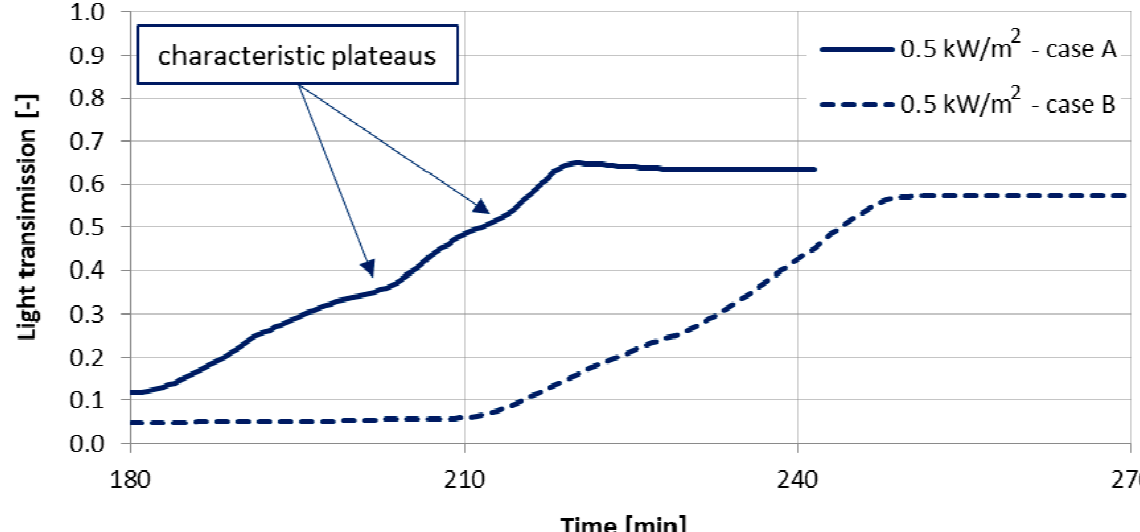
8 of 13 Figure 10. Direct light transmission versus time for an irradiance of 500 W/m 2 , case B. 3.2. Direct Light Transmittance during Change of Phase As it was expected that the phase change dynamics would differ during experiments regarding irradiance. Moreover, the behaviour of the PCM in the transition period de- pended on the glass configuration (case A and B). To better understand the complex opti- cal/thermal process the results were combined and compared assuming the same time for beginning of melting. The results in the 500 W/m 2 case are presented in Figure 11, while those for 1000 W/m 2 can be seen in Figure 12. The “plateau” effect can be better seen in